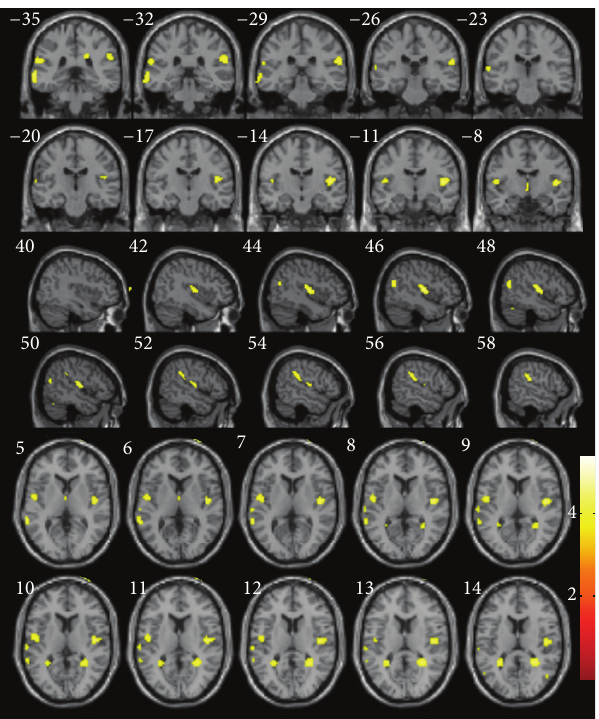
Figure 1: Voxel-based morphometry results showing regions positively correlated with the delayed free-recall verbal memory subdomain of Parkinson disease dementia-short screen (yellow, uncorrected 𝑃 < 0.001